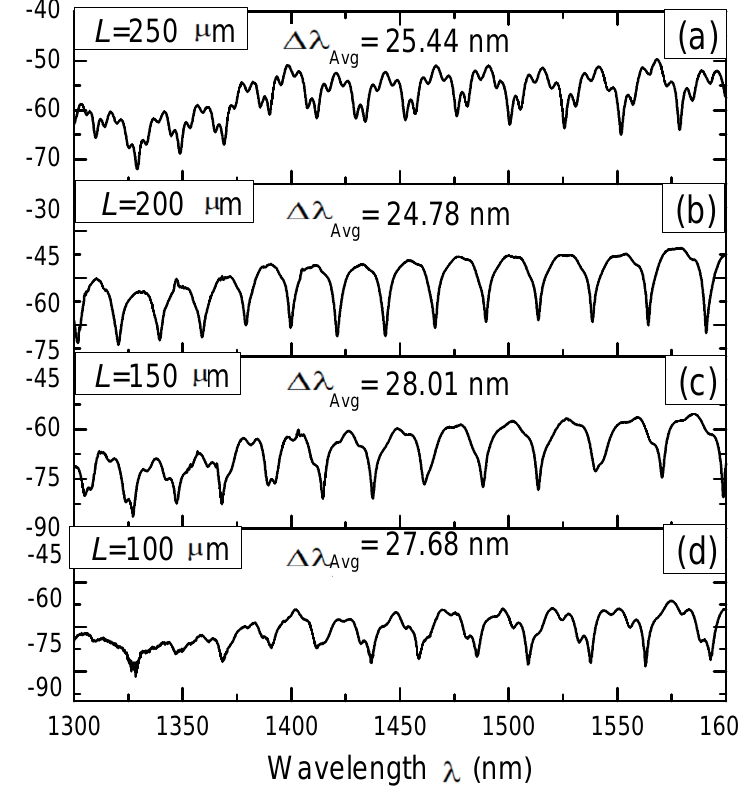
Figure 5. Measured IFPI reflection